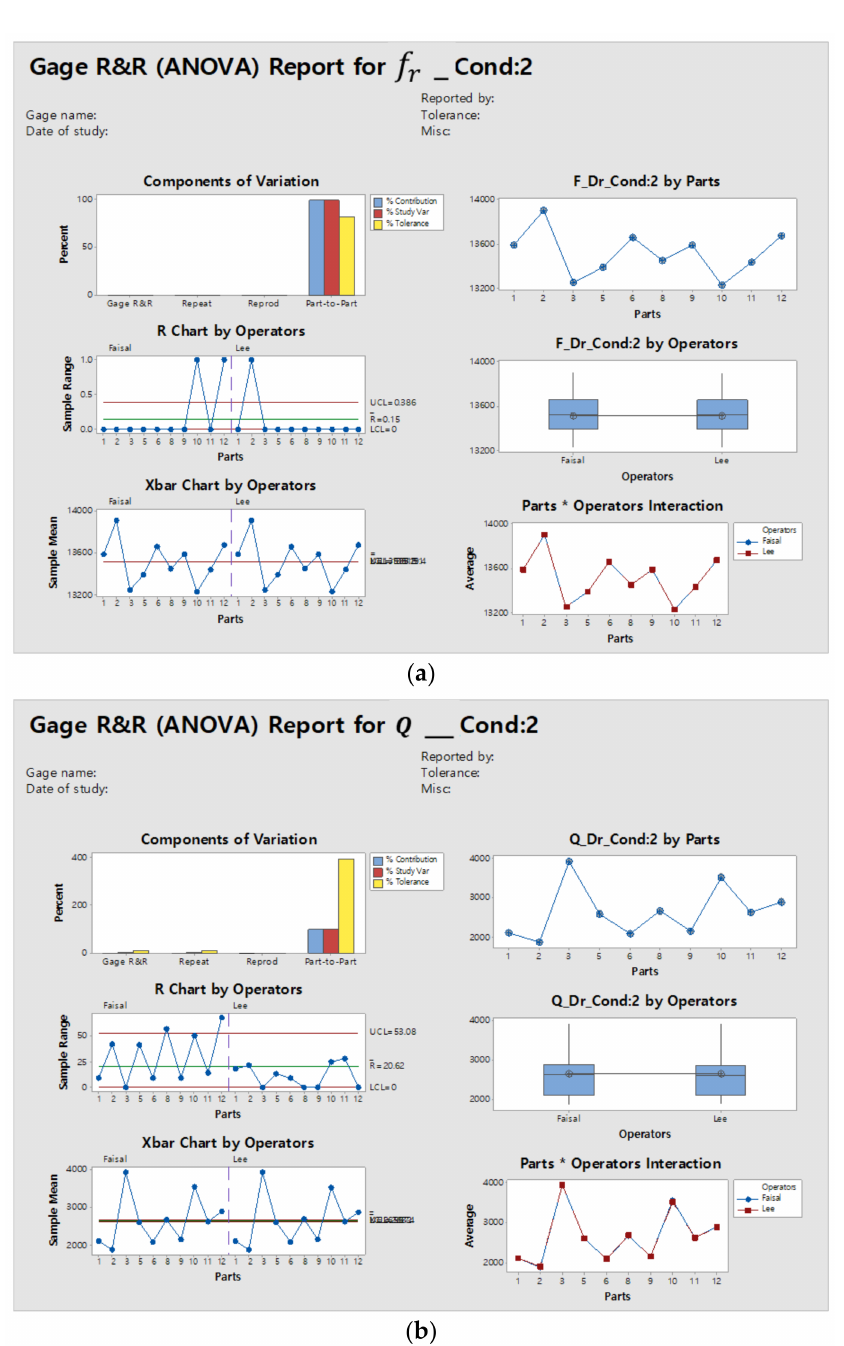
Figure 8. Gage R&R ANOVA results for ( a ) the resonant frequency ( f r ) and ( b ) the Q factor for condition